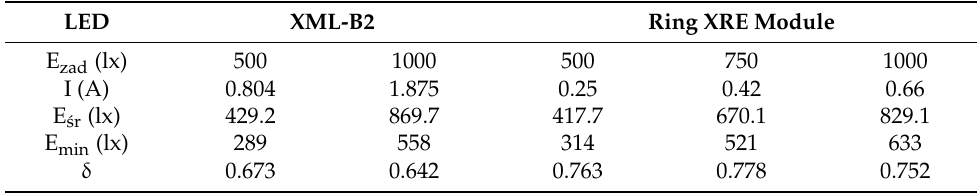
Table 3. Operating parameters of point light sources.